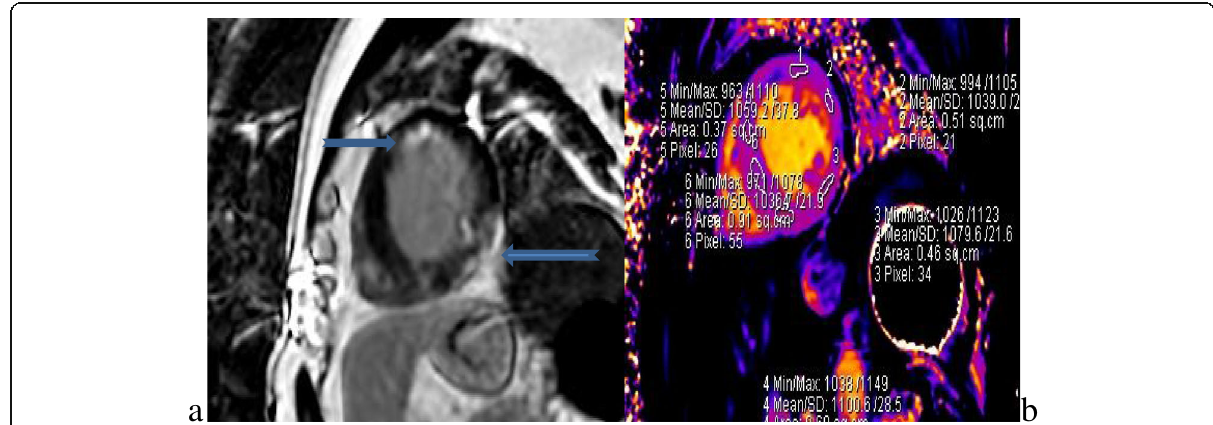
Fig. 4 66 Y male with history of coronary heart disease referred for myocardial viability a ) Late gadolinium enhancement (LGE) was found sub- endocardial enhancement of the anterior and inferolateral segments (arrows). b ) Non-contrast-enhanced T1 mapping shows that the native T1 value of the corresponding regions including LGE (1100 ms)